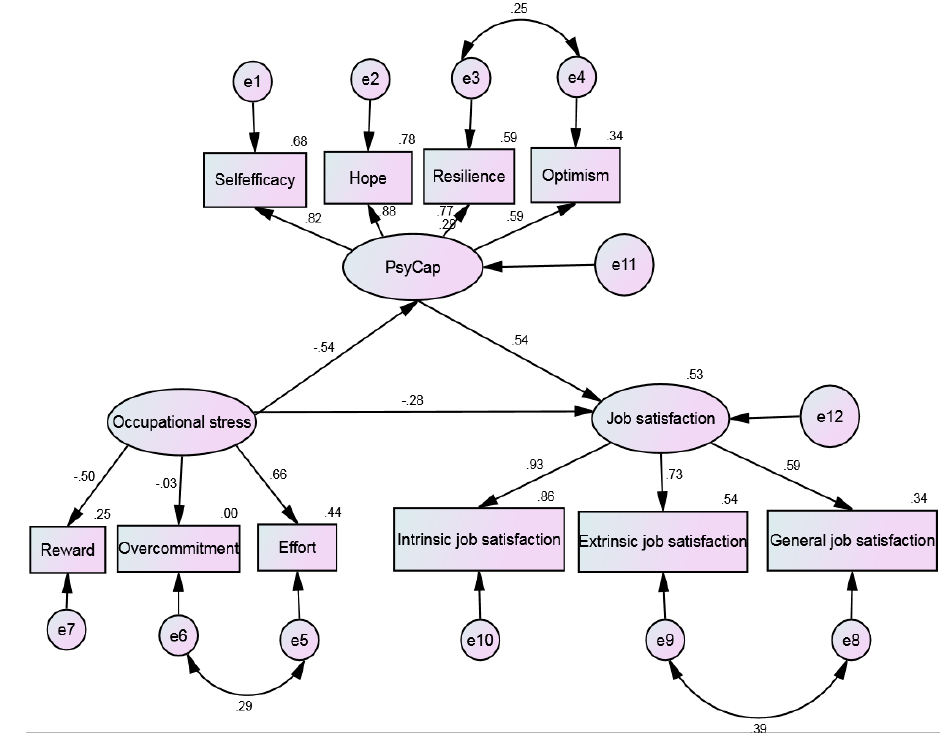
Figure 1. The structural equation model on the relationships between occupational stress, Job Figure 1. Satisfaction and Psychological Capital (PsyCap) among whole sample. e1–e10: the measurement error of each observed variable to estimate latent variable. e11–e12: the residual that may affect the endogenous latent variables except the exogenous latent variables.